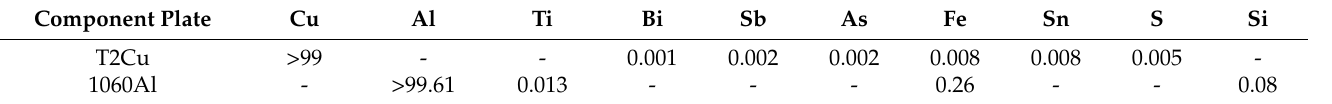
Table 1. Chemical composition of T2 Cu and 1060 Al